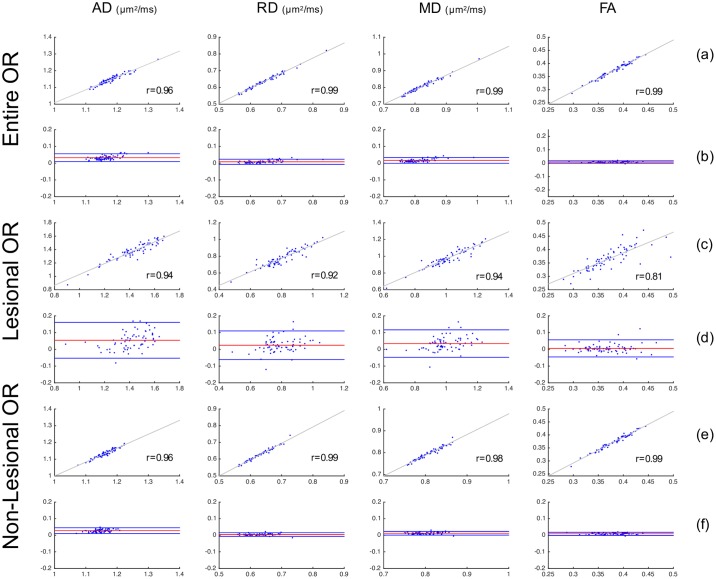
Comparison of OR diffusivity metrics between Template-OR and Histology-OR approaches.Row (a), (c), (e) are scatter plots with linear fitting; x-axis is Template-OR measurement and y-axis is Histology-OR measurement. r is the Pearson’s correlation coefficient. Row (b), (d), (f) are Bland-Altman plots for comparing two methods. x-axis is the mean of Template-OR and Histology-OR measurements. y-axis is the difference between Template-OR and Histology-OR measurement.